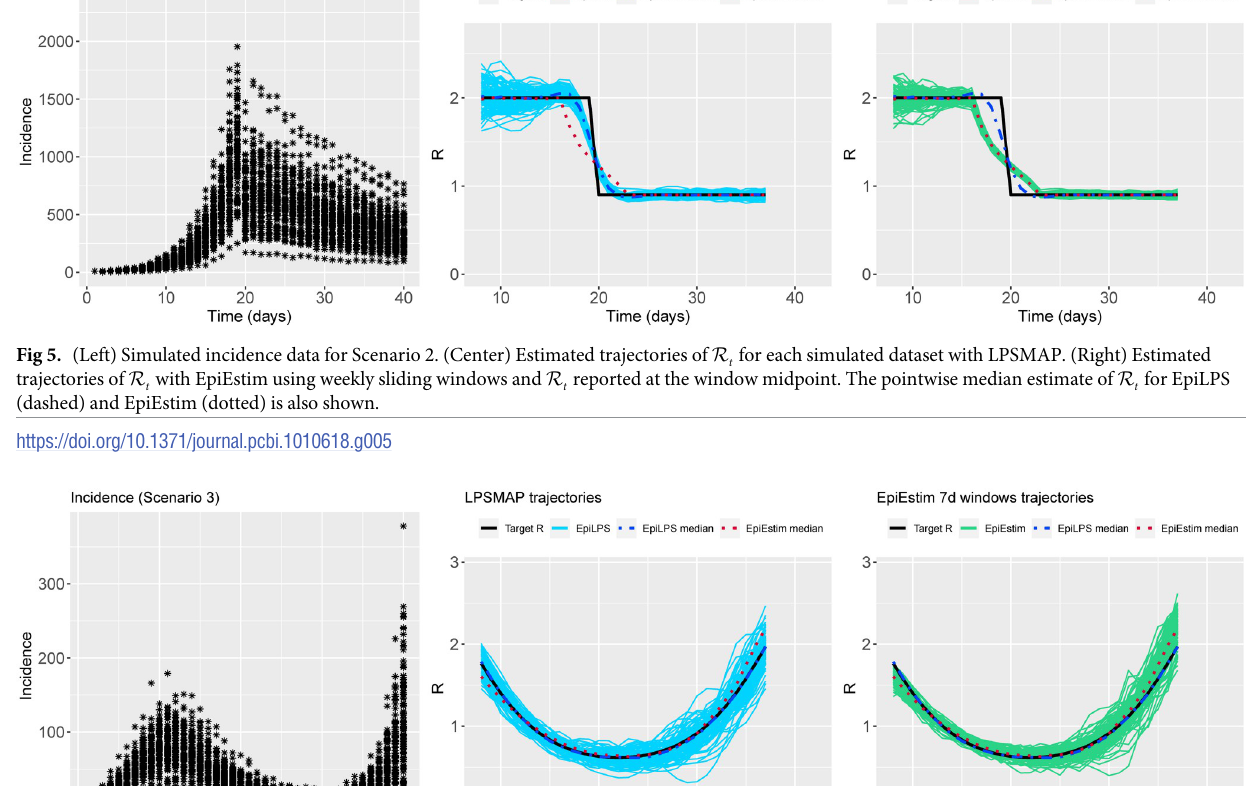
for each simulated dataset with LPSMAP. (Right) Estimated t reported at the window midpoint. The pointwise median estimate of R t